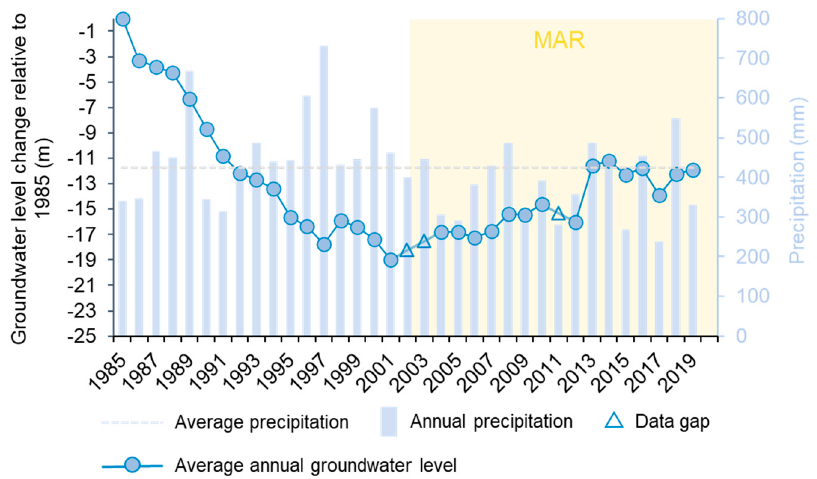
Figure 4. Average annual groundwater level relative to 1985, annual precipitation, and average precipitation (423 mm) in the Los Arenales groundwater body (LAGB) (2398 km 2 ). The period with managed aquifer recharge (MAR) implementation is shown as a yellow shade in the background.